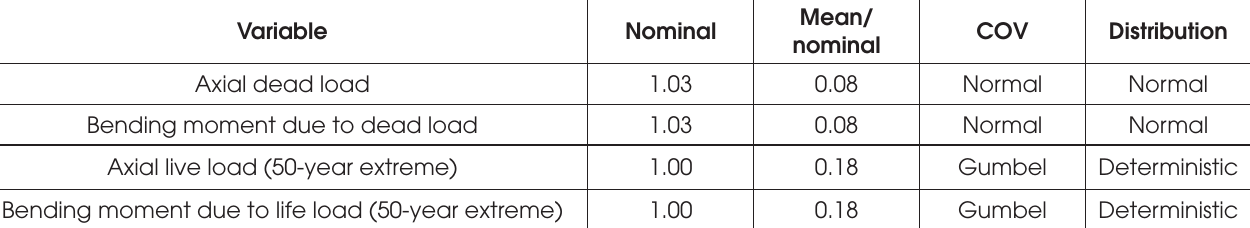
Bending moment due to life load (50-year extreme)